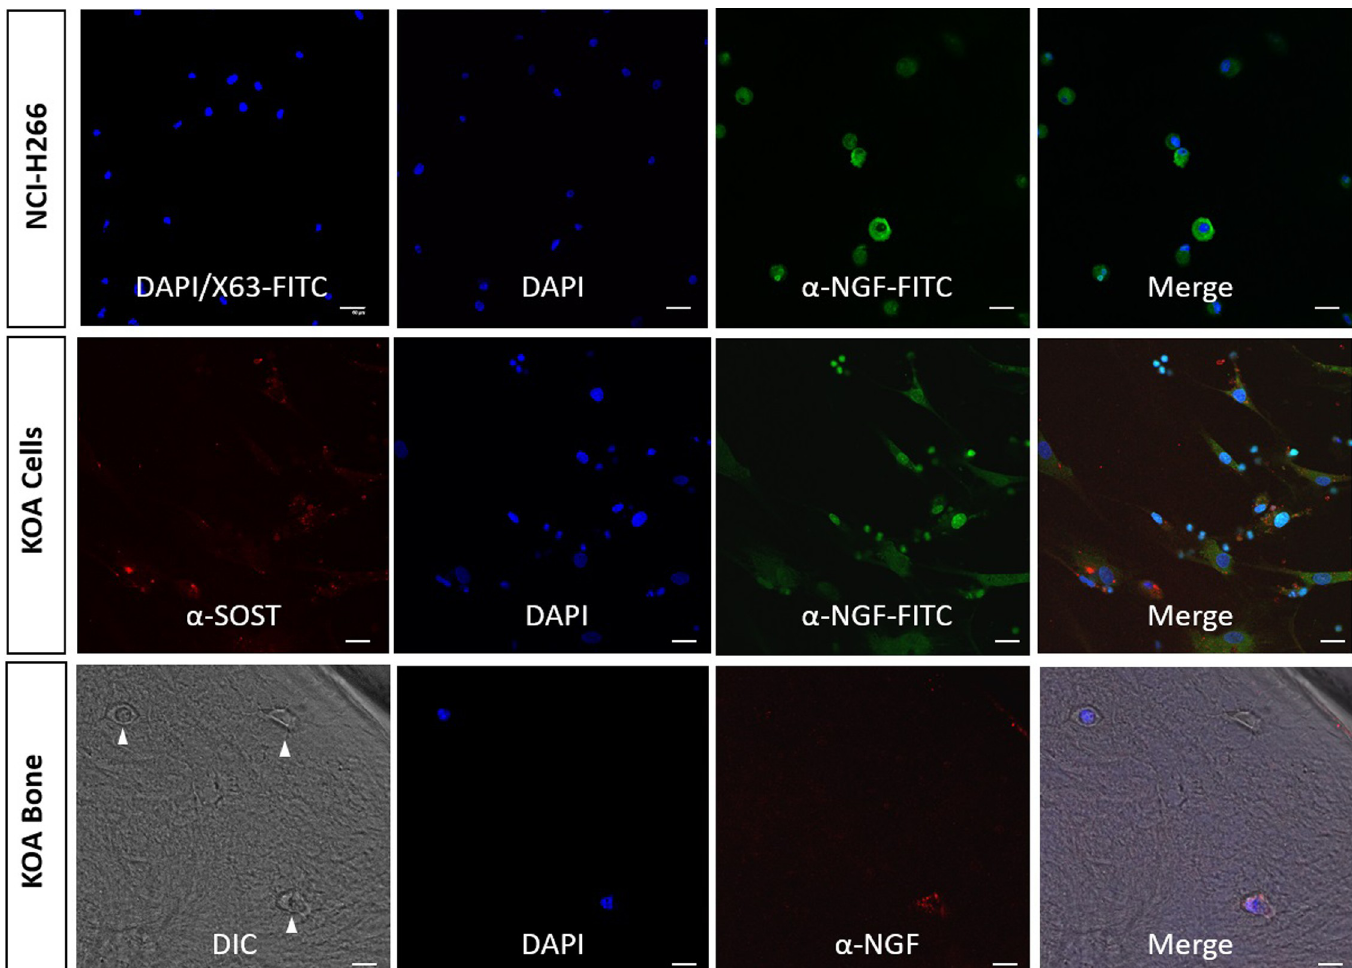
Fig 2. NGF expression in isolated human osteocytes and in KOA bone. Directly conjugated α -NGF MAb was tested against NCI-H266 cells and compared against a directly conjugated negative control antibody, X-63 ( upper row ). Fractions IV-VI of a KOA bone digest were similarly stained for NGF, and staining compared against the expression of the osteocyte marker SOST/sclerostin ( middle row ). Dual staining revealed intracellular but not co-localised staining for both NGF and SOST in these cells. Specificity of staining was confirmed using negative control IgG 1 MAb. Finally, NGF positivity was evident in osteocytes (white arrows) in situ in decalcified KOA bone ( bottom row ), here using unconjugated α -NGF MAb, as described in Materials and methods. Bone morphology is revealed by digitial interference contrast (DIC). In all cases nuclei were visualised by DAPI stain (blue). Scale bars represent 50 μ m.